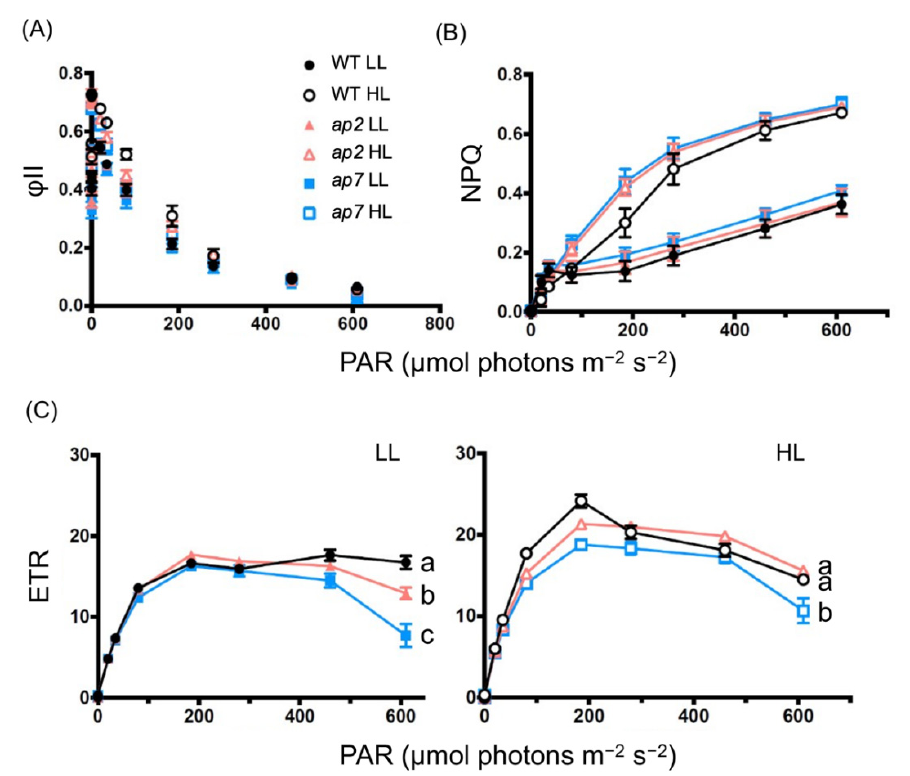
Figure 4. Photosynthetic parameters of ap2 and ap7 after treatment with low or high light. ( A ) ϕ II, ( B ) NPQ, and ( C ) ETR of WT, ap2 , and ap7 cells after treatment with low light (LL; white, 50 µ mol photons m − 2 s − 1 ) or high light (HL; white, 1000 µ mol photons m − 2 s − 1 ) (n = 3, mean ± S.E.M.). In ( C ), different letters indicate significant differences ( p < 0.05, one-way ANOVA and Tukey’s honest significance difference (HSD)). PAR: photosynthetically active radiation.